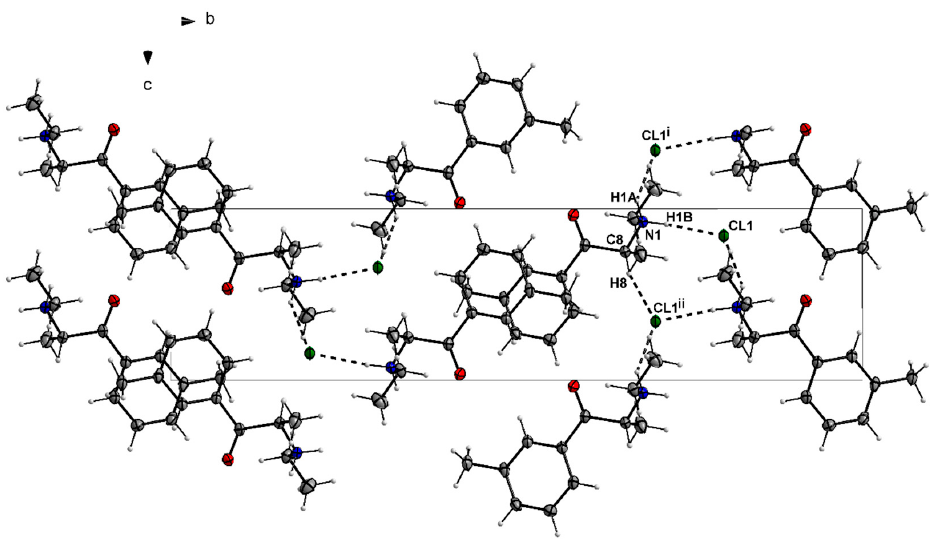
Figure 10. Part of the crystal structure of Compound 4 viewed along the a axis, showing H-bonding between neighboring ions (dashed lines). Symmetry codes: (i) x , − y + 3 / 2, z − 1 / 2; (ii) x , − y + 3 / 2, z + 1 / between neighboring ions (dashed lines). Symmetry codes: (i) x , − y + 3/2, z − 1/2; (ii) x , − y + 3/2, z + 1/2.